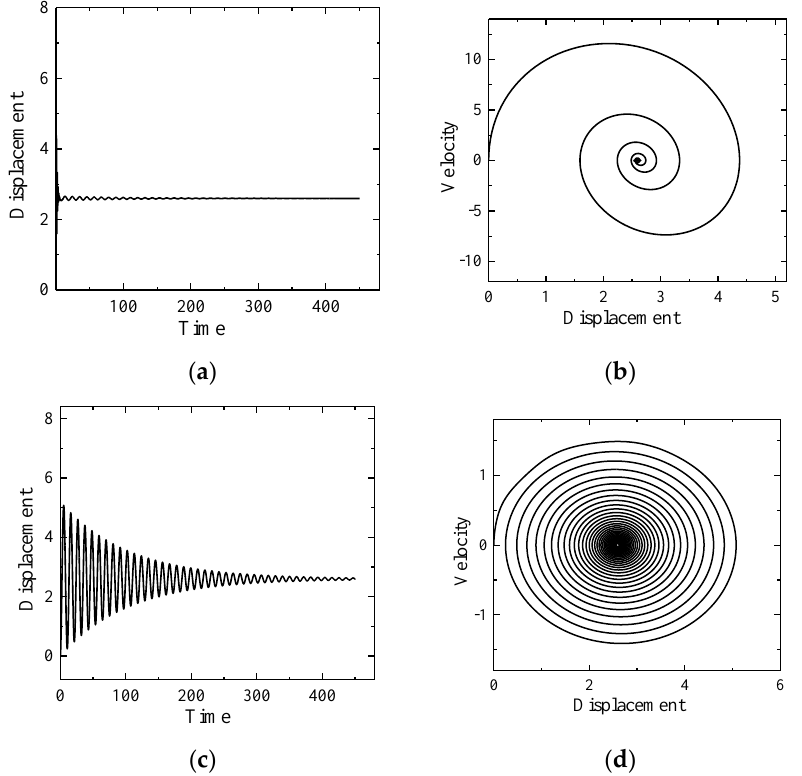
Figure 15. Evolutions of the displacement and speed-displacement diagram of brake disc and brake shoe at the initial braking speed of 20 m / s. ( a ) Evolution of the displacement of the brake shoe. ( b ) Evolution of the speed-displacement diagram of the brake shoe. ( c ) Evolution of the displacement of the brake disc. ( d ) Evolution of the speed-displacement diagram of the brake disc. Energies 2020 , 13 , x FOR PEER REVIEW 17 of 23